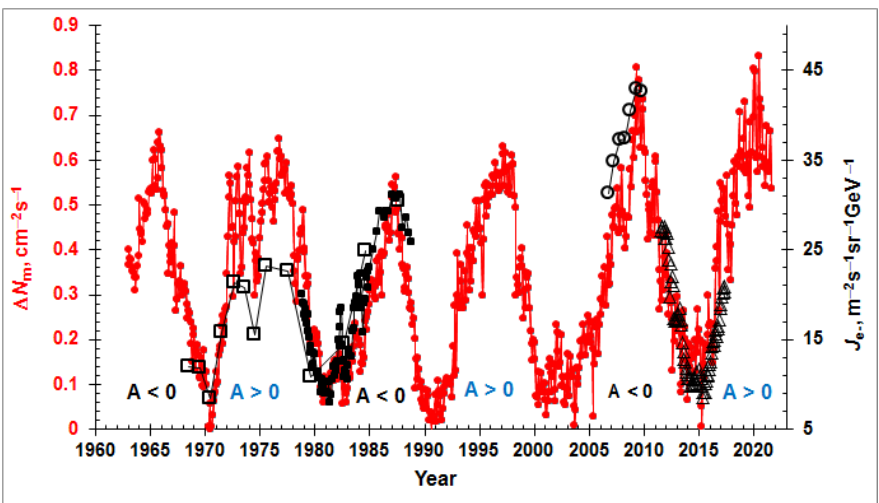
Figure 4. Monthly averaged values of charged particle fluxes in the atmosphere (red points, left vertical axes) at the maximum of the cascade curve, ∆ N m (see text for explanation) [3]. The primary electron intensities with energy E e = (0.9–1.1) GeV also are shown with black color symbols (right vertical axes): open squares—electron data obtained with balloons [7]; black squares—data obtained in space experiments [7]; open cycles—data from the PAMELA space experiment [8]; open triangles—data from the AMS-02 space experiment on board the ISS [9]. The positive and negative phases of the 22-year solar magnetic cycle are shown as A > 0 and A < 0, correspondingly. As one can see from Figure 4, in the period 1974 – 1978, a plateau-like time depend- ence was observed in cosmic rays produced by primary protons and nuclei (red curve).